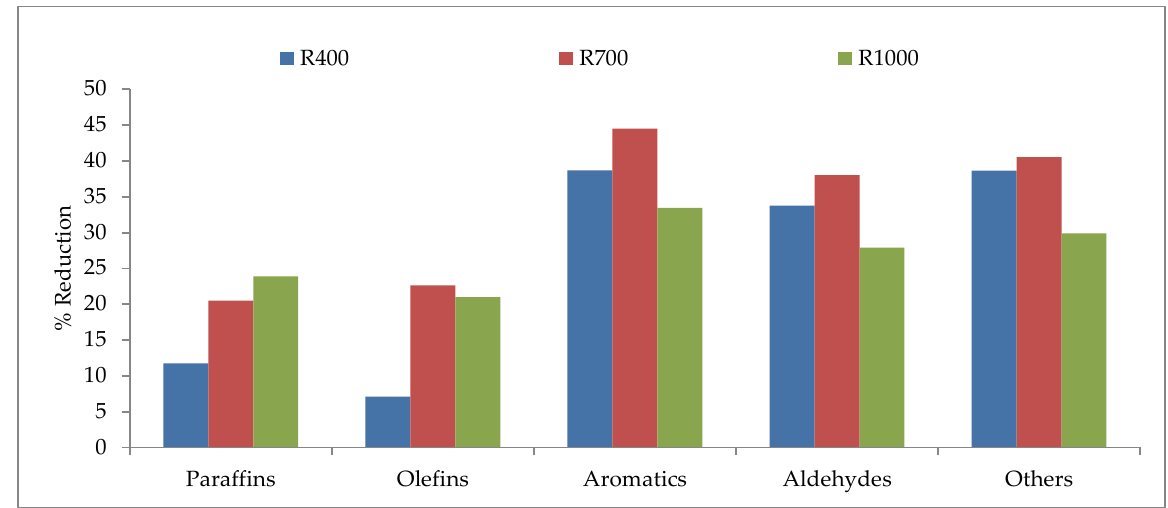
Figure 12. Reduction obtained for the different families of compounds in the total particular matter collected in the study of the stirring rate (rpm) at the first step of the synthesis with fixed conditions of time, 24 h, and temperature (40°).